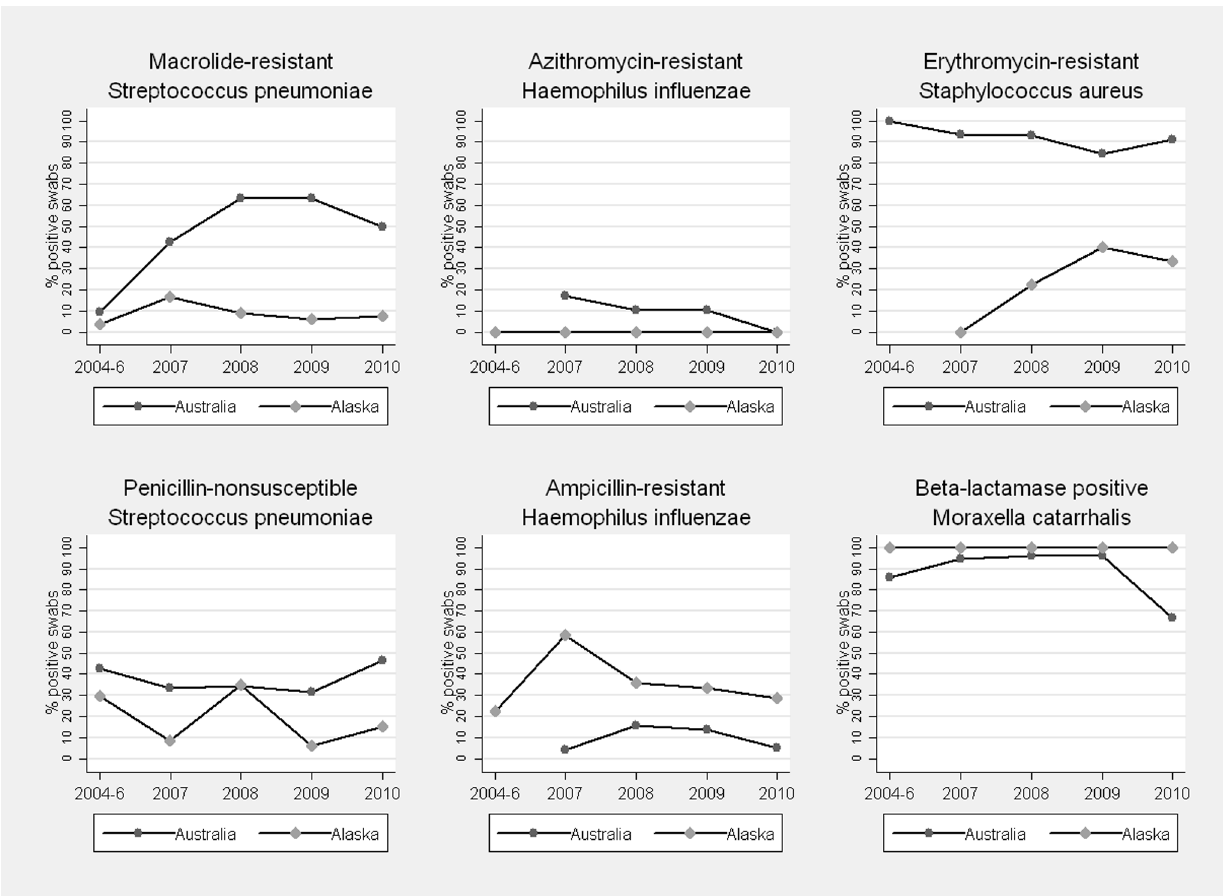
Figure 2. Pathogen resistance (proportion of carriers) by study year in Australian and Alaskan children.